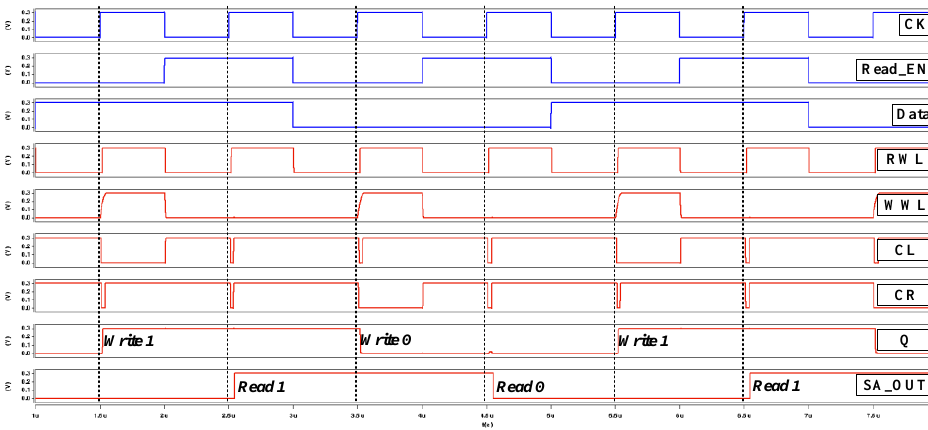
Figure 17. Post-layout simulation waveforms @300mV/TT corner.